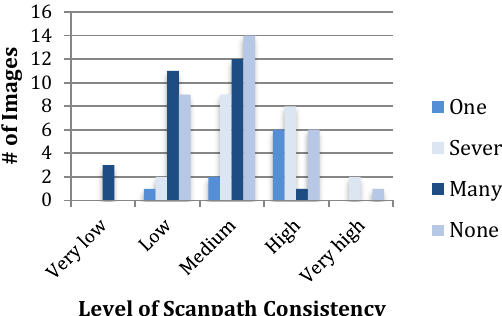
Figure 1 : The number of images in Farnand (2013) that were determined qualitatively to have Very Low to Very High scanpath consistency grouped by presence of focal points. ‘Several’ indicates 2-4 focal points while ‘Many’ indicates five or more.